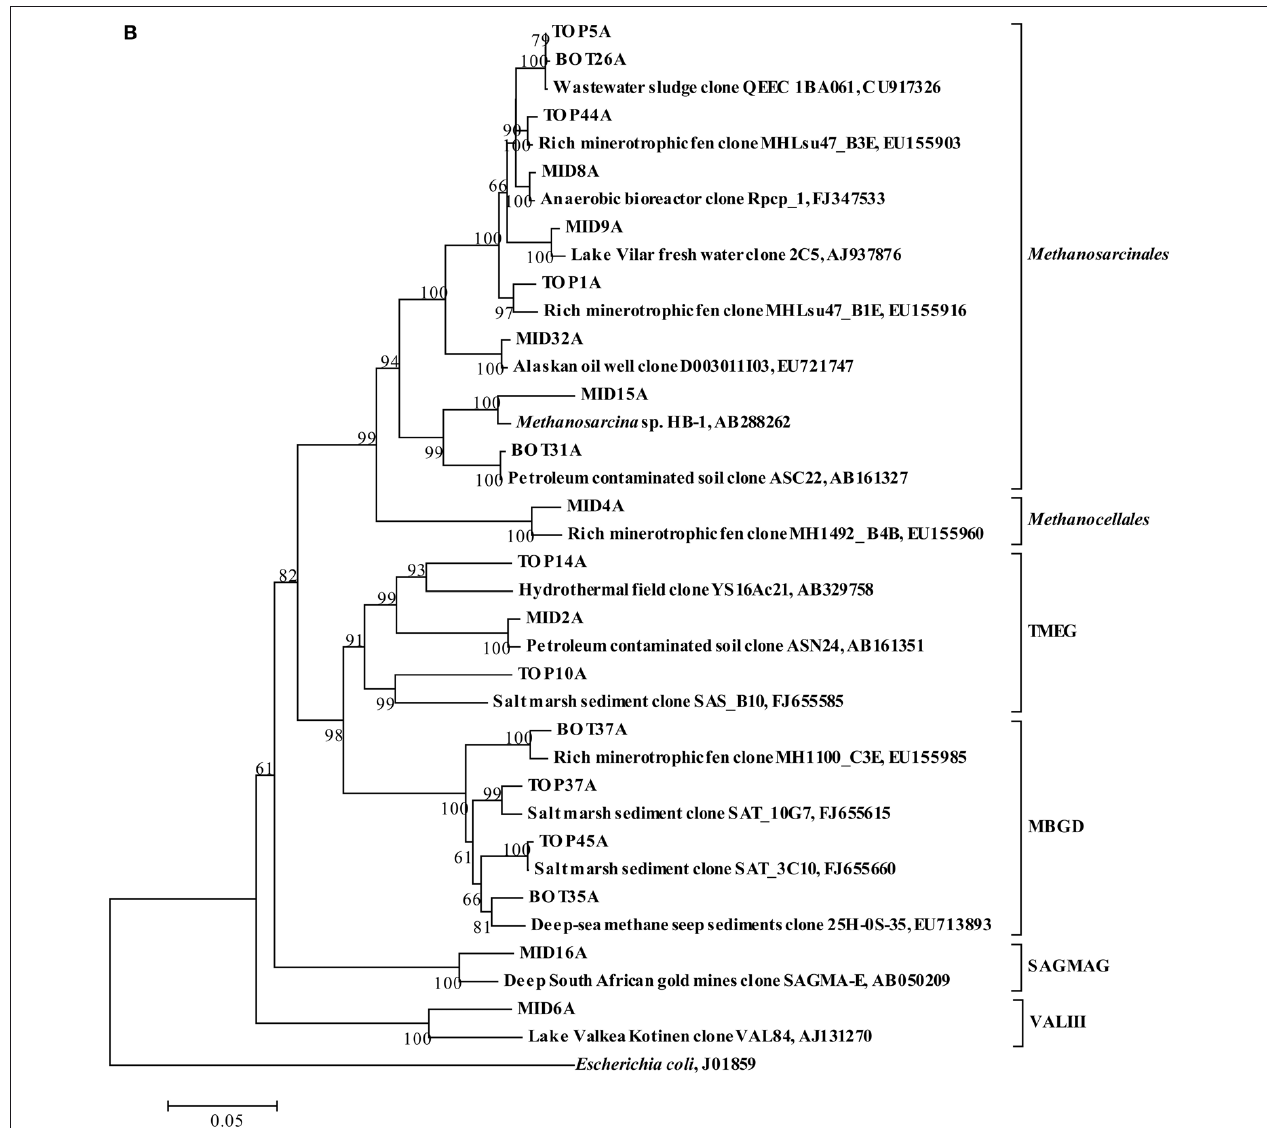
FIGURE A2 | Phylogenetic trees showing the affiliations of crenarchaeal (A) and euryarchaeal (B) 16S rRNA gene sequences retrieved from this study with selected reference sequences. The clones from the top, middle, and bottom layers are differentiated as TOP, MID, and BOT, respectively. The trees were constructed by the neighbor-joining, using nearly full-length aligned nucleotides sequences with E. coli J01859 as outgroup. Bootstrap values are based on 1000